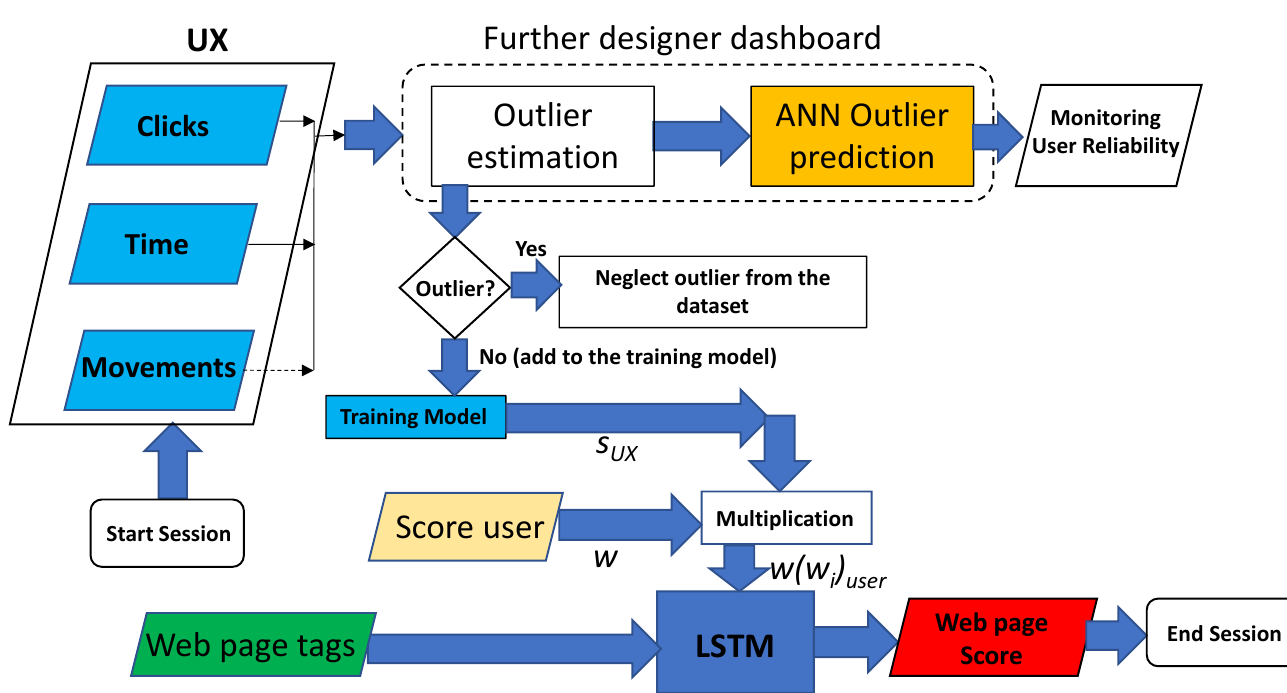
Figure 3. Flowchart describing the proposed model to estimate scoring for the best web page using UX, ANN, and LSTM algorithms. Table 2. Web page preliminary